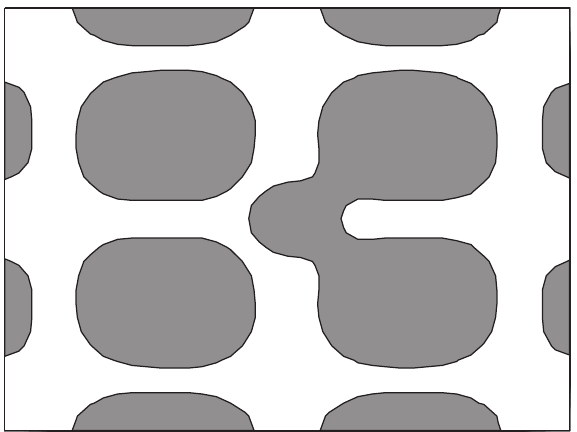
Figure 14: Optimized design of the damping layer for the 5th modal with one hole as the initial design ( τ � 0 .